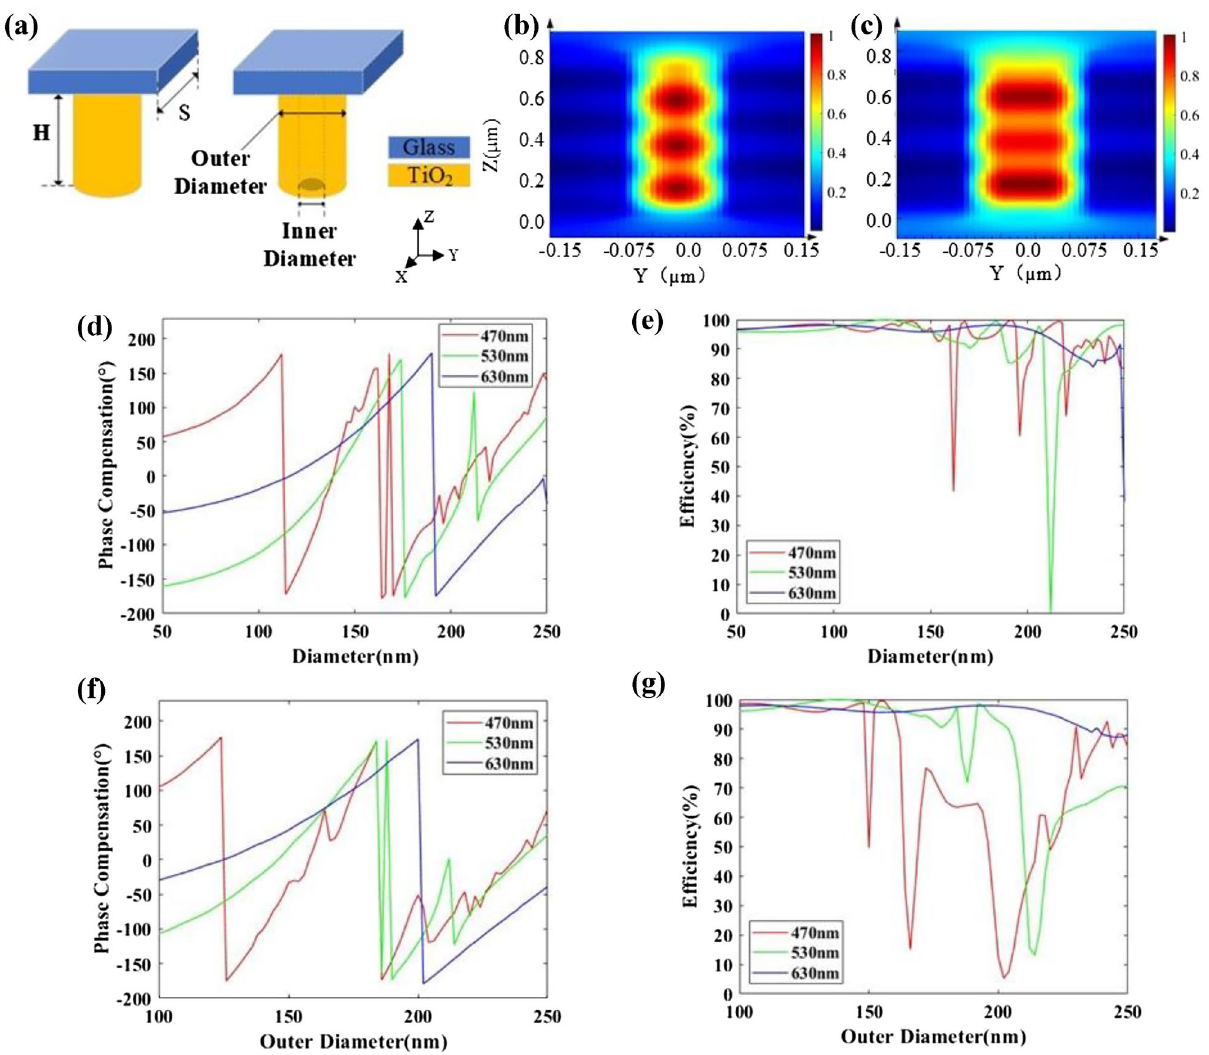
Figure 2. ( a ) Schematic of the nanostructure in deflecting layer. The TiO 2 nanopillar with a height of 800 nm is placed under a glass substrate. The period of the nanostructure is 300 nm. ( b , c ) Magnetic field intensity distribution of cylindroid nanopillar and annular nanopillar at the wavelengths of 530 nm, respectively. ( d , e ) Phase compensation and transmission efficiency with the change of diameter of cylindroid nanopillars at the wavelengths of 470 nm, 530 nm and 630 nm, respectively. ( f , g ) Phase compensation and transmission efficiency with the change of outer diameter and the inner diameter of 50 nm of annular nanopillars at the wavelengths of 470 nm, 530 nm and 630 nm,